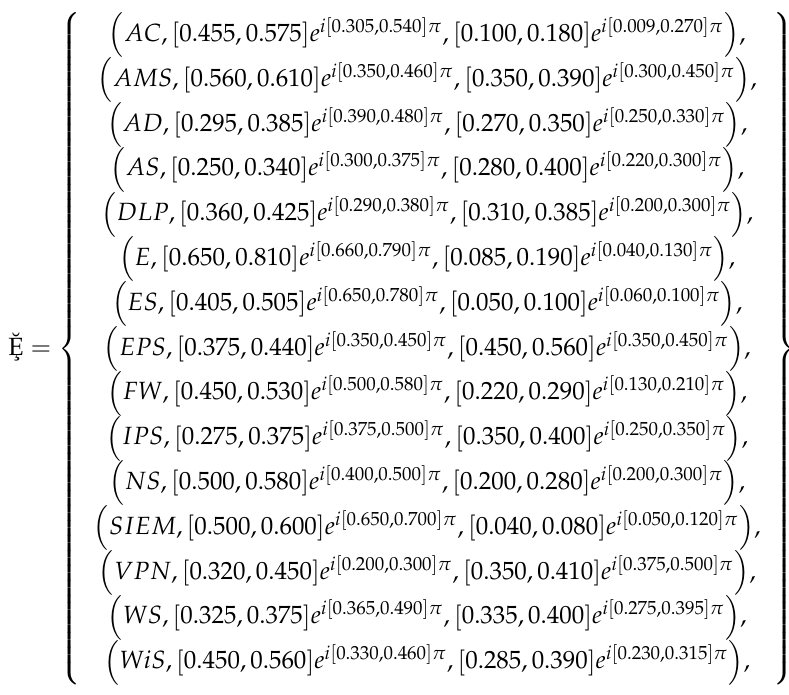
Table 3. IVCI-partial order-FR ¯R